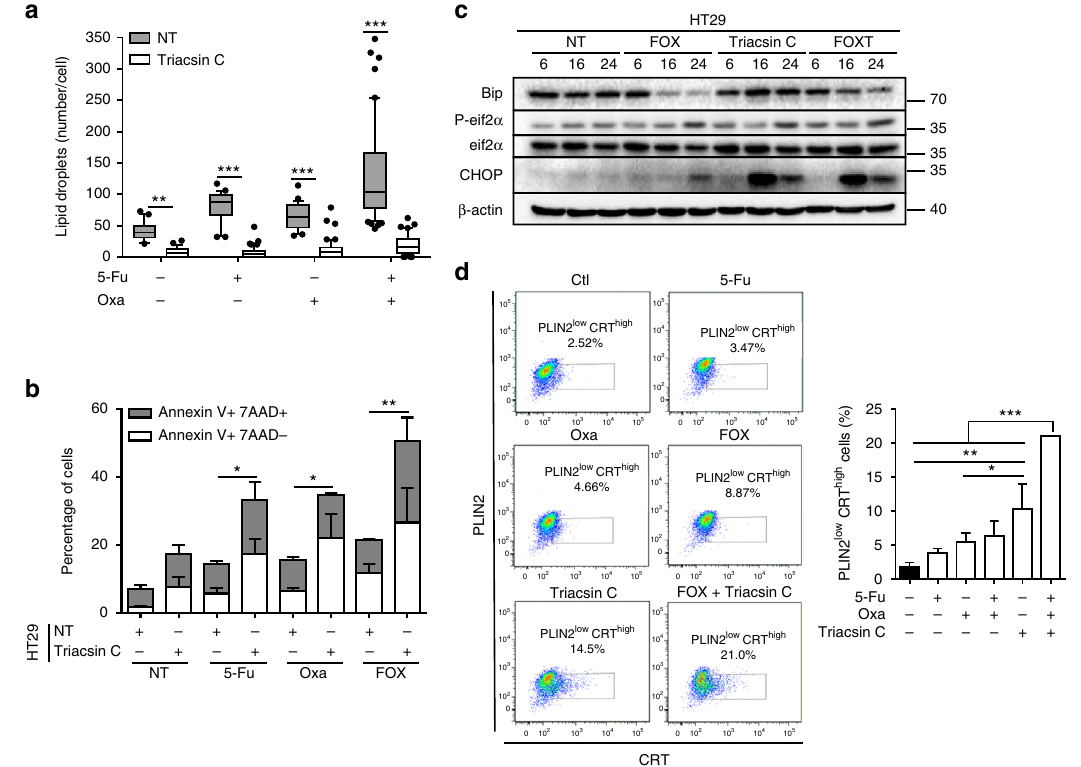
Fig. 7 Inhibition of LD production restores chemotherapy-induced ER stress. a Nile red LD staining in HT29 cells treated with chemotherapy in the absence (NT) or presence of triacsin C (10 µ M). Mean number of LDs /cell with whiskers denoting 1st and 99th percentiles. P values were determined by